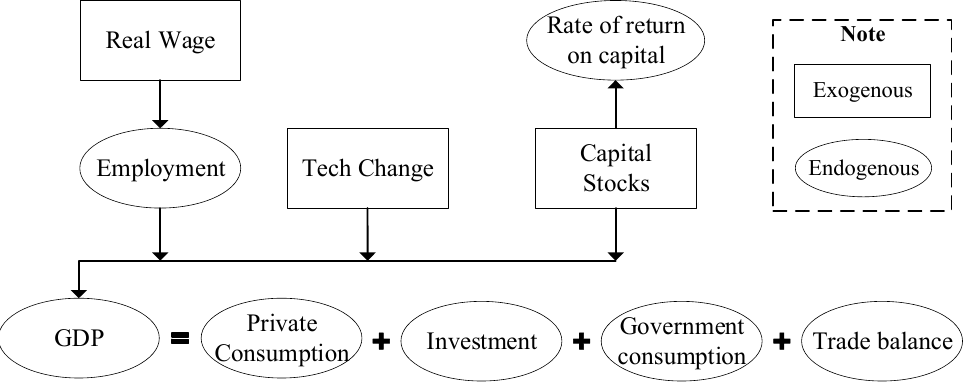
Figure 2. The theoretical framework of the CHINAGEM model. Source: Cui et al. [26]. To save space, this study briefly introduces the nesting structure of the inputs for the producing sectors (Figure 3). On the top level, the total input of each producing sector is composed of the primary factor and intermediate inputs, which is depicted by a Leontief function, assuming that their utilisation is fixed proportionally to the total input. On the next level, the primary factor input consists of labour, capital, and land, as depicted by the constant elasticity of substitution (CES) function with a substitution elasticity of 0.5. The intermediate goods include domestic and foreign goods according to the Armington assumption, suggesting that domestically produced goods and foreign goods have incomplete substitution. On the bottom, following Mu et al. [50], the labour input of each producing sector is split into 24 types along with three properties of labourers. education levels (elementary school, middle school, high school, junior college, regular obtained (2 × 2 × 6 = 24). A CES function is employed to describe the substitution between different types of labourers with an elasticity of 0.5.